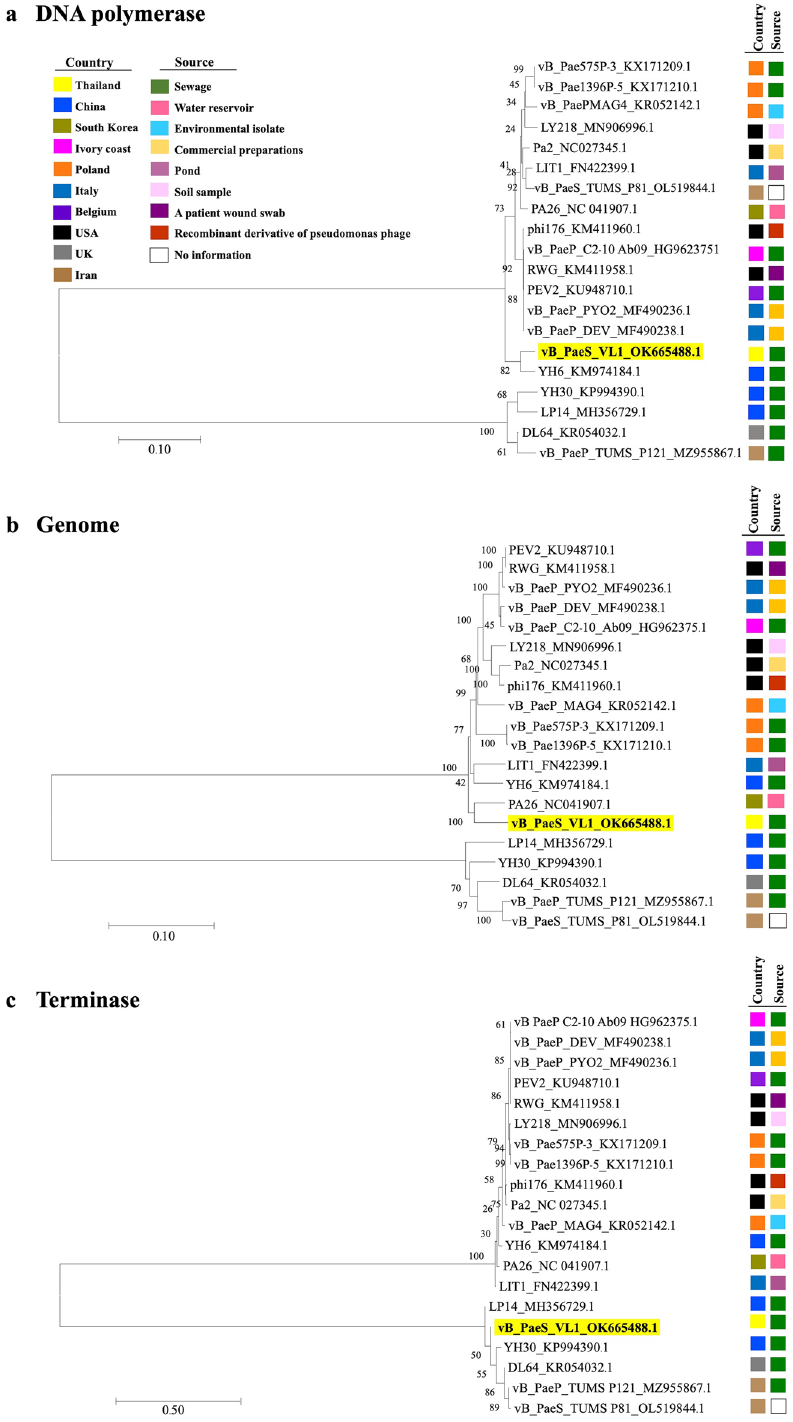
Figure 3. Neighbor-Joining phylogenetic tree based on ( a ) DNA polymerase gene, ( b ) complete genome sequences, or ( c ) terminase large subunit gene of phage vB_PaeS_VL1 and related phages in Litunarviruses. Numbers are shown next to the branches indicated by the percentage of replicate trees of the bootstrap test (1000 replicates). The evolutionary distances were processed using the Maximum Composite Likelihood method. The isolation source and country of each species are presented with a different colored